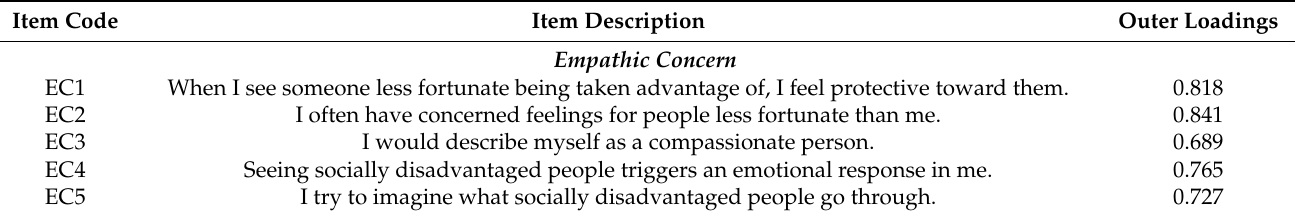
Table 2. Questionnaire items and factor